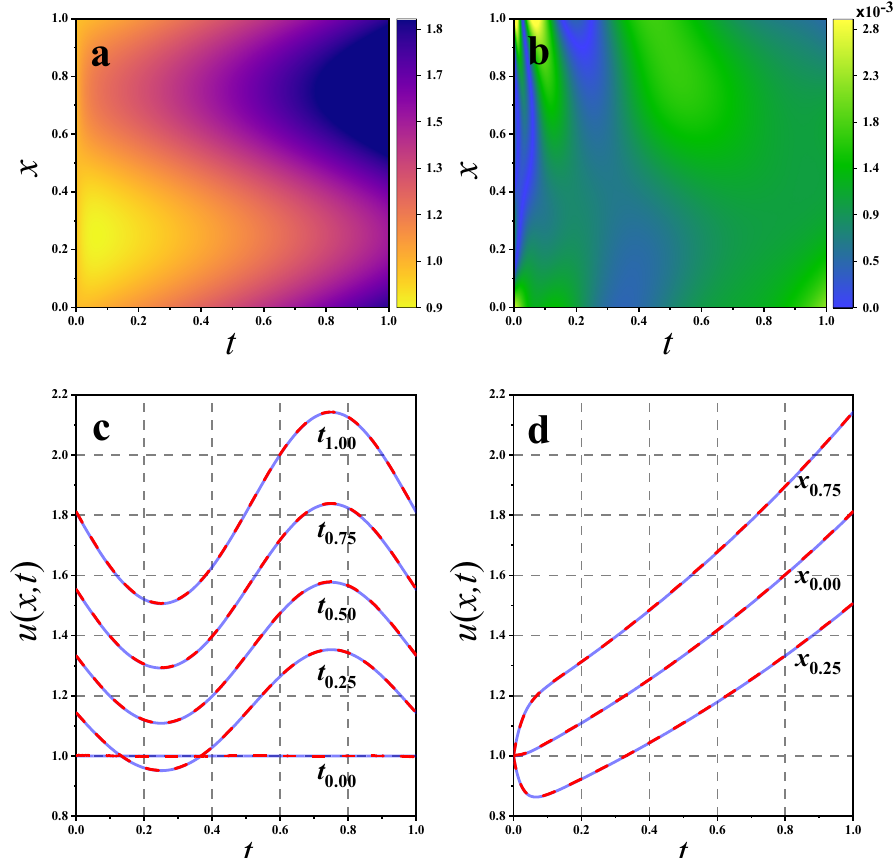
Figure 6. Comparison of PINN results with numerical results. ( a ) The overall view in the two dimensional space of PINN results u ( x , t ); ( b ) Diagram of the difference between PINN results and numerical results; ( c ) 0.00, 0.25, 0.50, 0.75, 1.00 ; ( d ) The accuracy in one- The accuracy in one-dimensional space with given t = 0.00, 0.25, 0.75 . The blue dotted line represents the numerical results and the dimensional space with given x = red line represents PINN results.